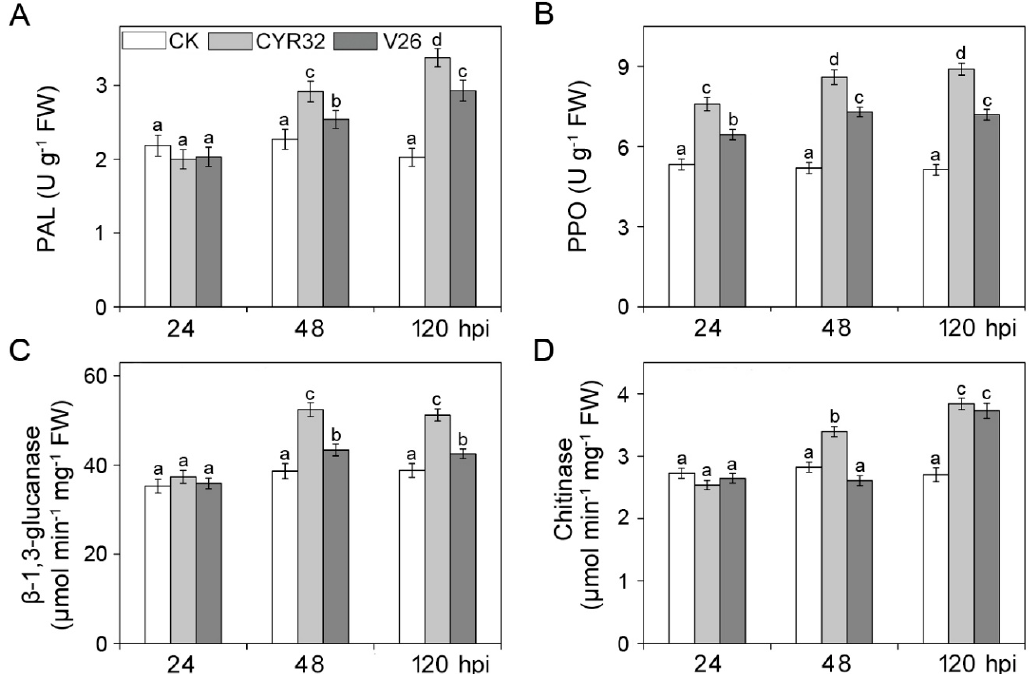
Figure 5. The activities of PAL, phenylalanine ammonia lyase ( A ). PPO, polyphenol oxidase ( B ). β -1,3-glucanase ( C ) and chitinase ( D ) in wheat cultivar CM42 inoculated with CYR32 and V26. Bars represent standard deviations (SD), which were calculated from four independent biological replicates ( n = 4). Different letters note significant differences among different treatments ( p < 0.05) following Duncan’s multiplication range test. CK, un-inoculated wheat plants. 24–120 hpi represent 24, 48, and 120 h post-inoculation.